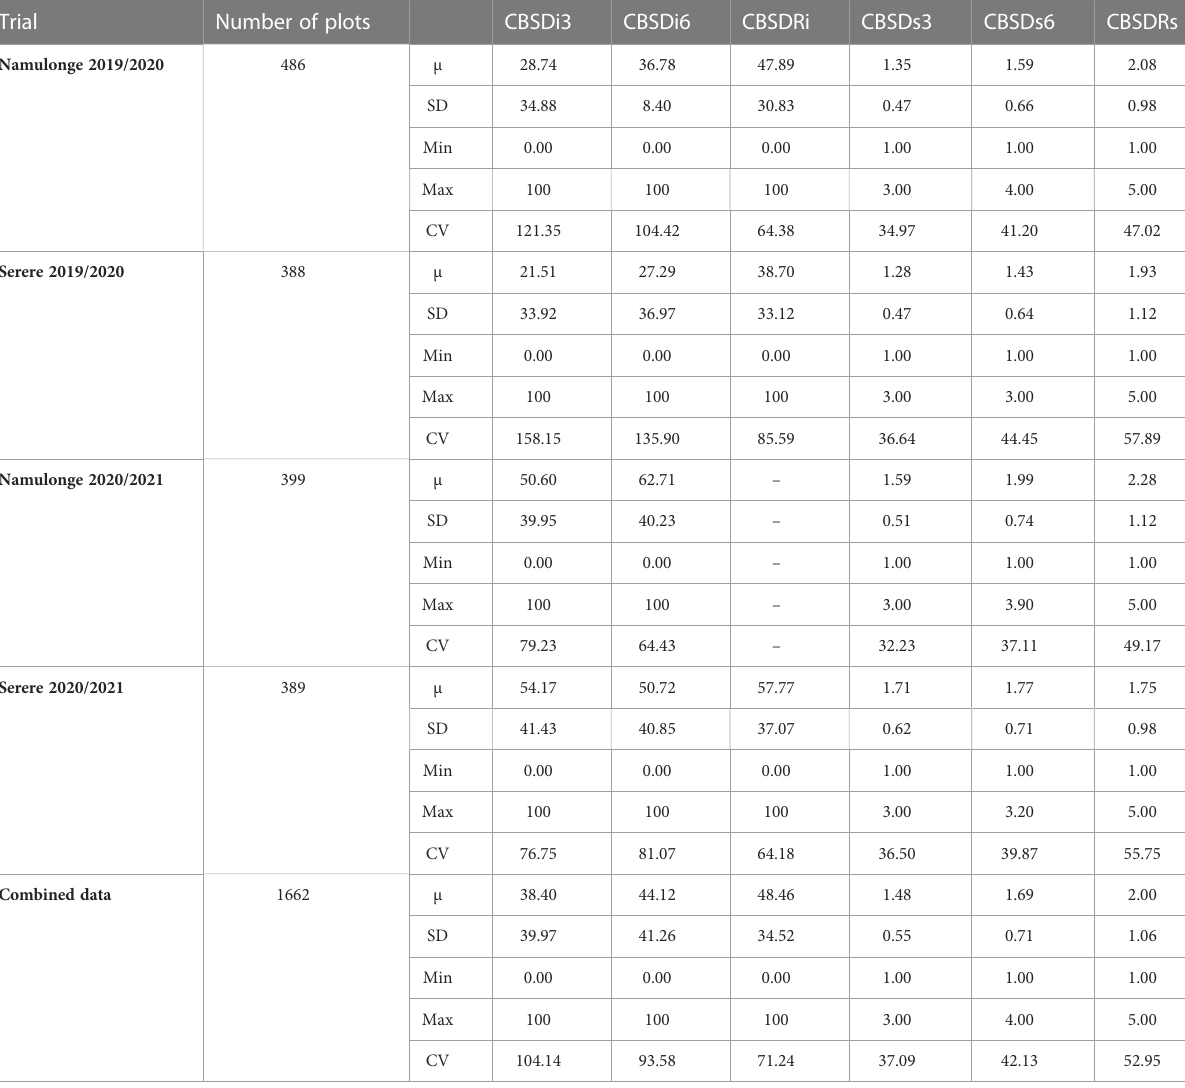
TABLE 1 Descriptive statistics of C2 seedling and clonal evaluation trials evaluated at Namulonge and Serere in 2019/2020 and 2020/2021 seasons. Trial